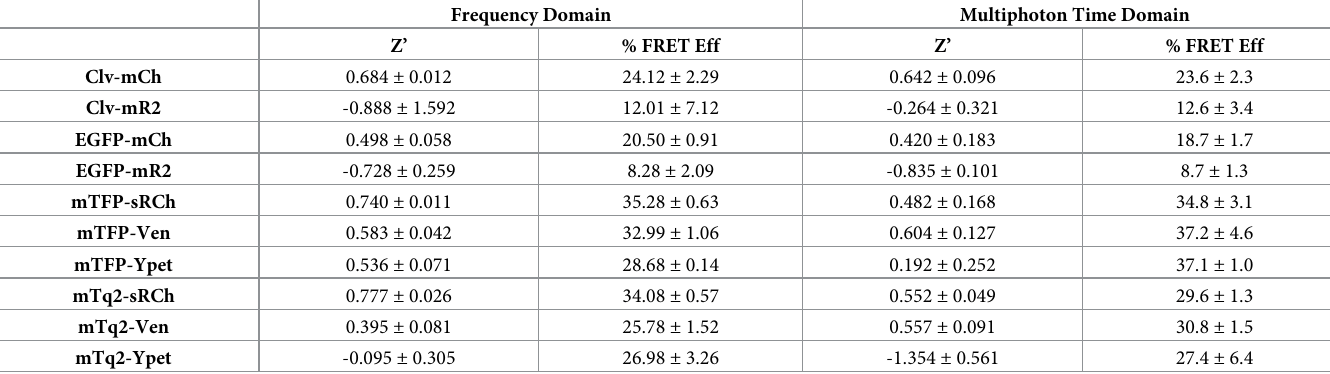
Table 4. Assay potential (Z’) and FRET efficiency under frequency and time domain FLIM conditions over 10 minute time